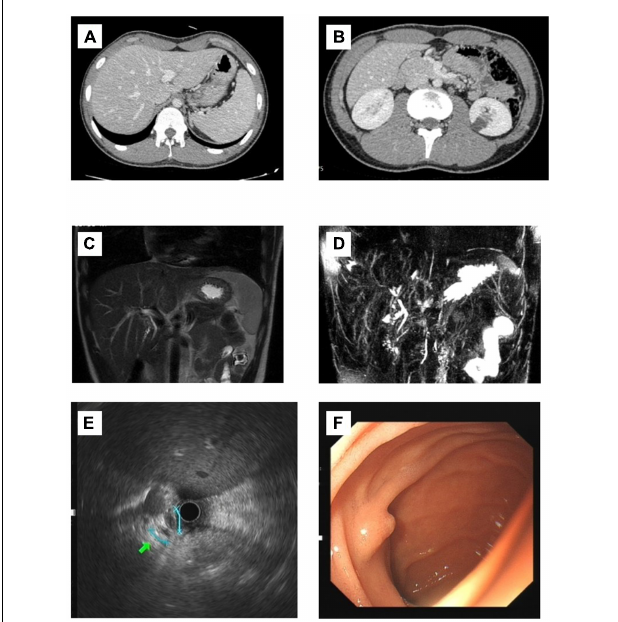
FIGURE 1 | Imaging findings of the patient. (A,B) CT: No pathological findings were found. No dilatation of intrahepatic and external bile ducts was noted. There was no thickening or enhancement of extrahepatic bile ducts. The gallbladder is collapsed without bile filling; (C,D) MRCP: Possible stenosis at the beginning of the common hepatic duct. (E) Endoscopic ultrasonography: The extrahepatic bile duct was fine without dilation, and no definite obstruction was observed. (F) Gastroscopy: The size and morphology of the duodenal papilla were normal.